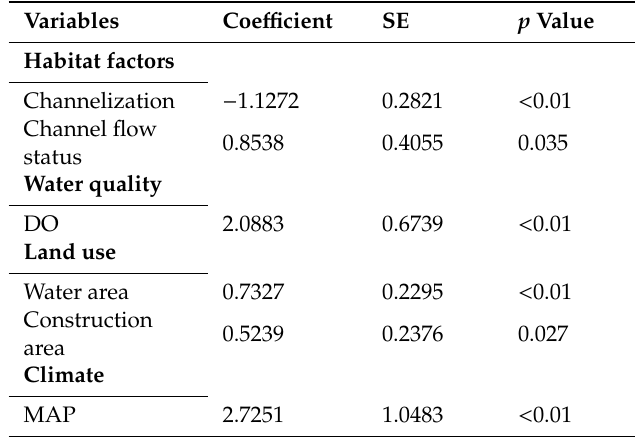
Table 4. Associations between environmental variables and the number of non-native fish species.